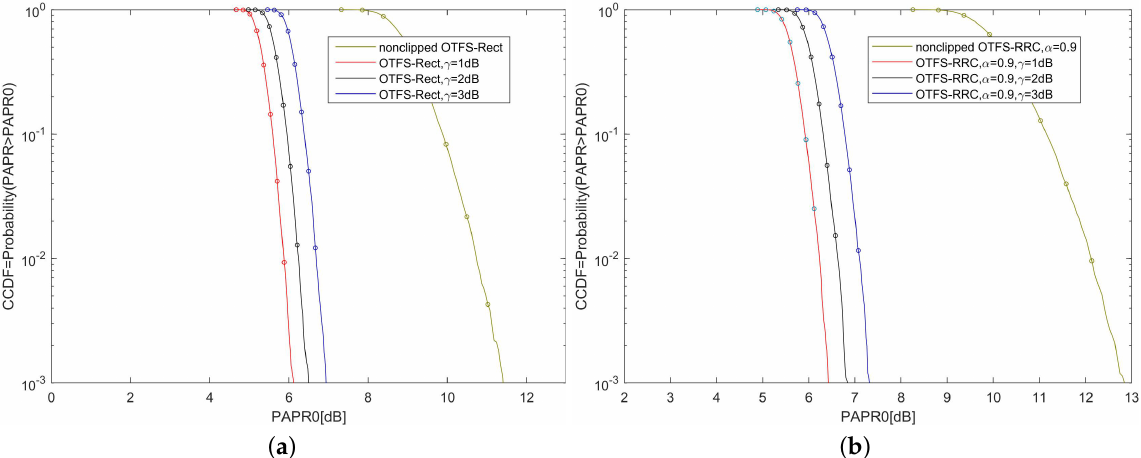
Figure 4. ( a ) PAPR distribution for the OTFS-Rect signal with different clipping ratio γ ; ( b ) PAPR distribution for the OTFS-RRC signal with different clipping ratio γ ( α = 0.9 )